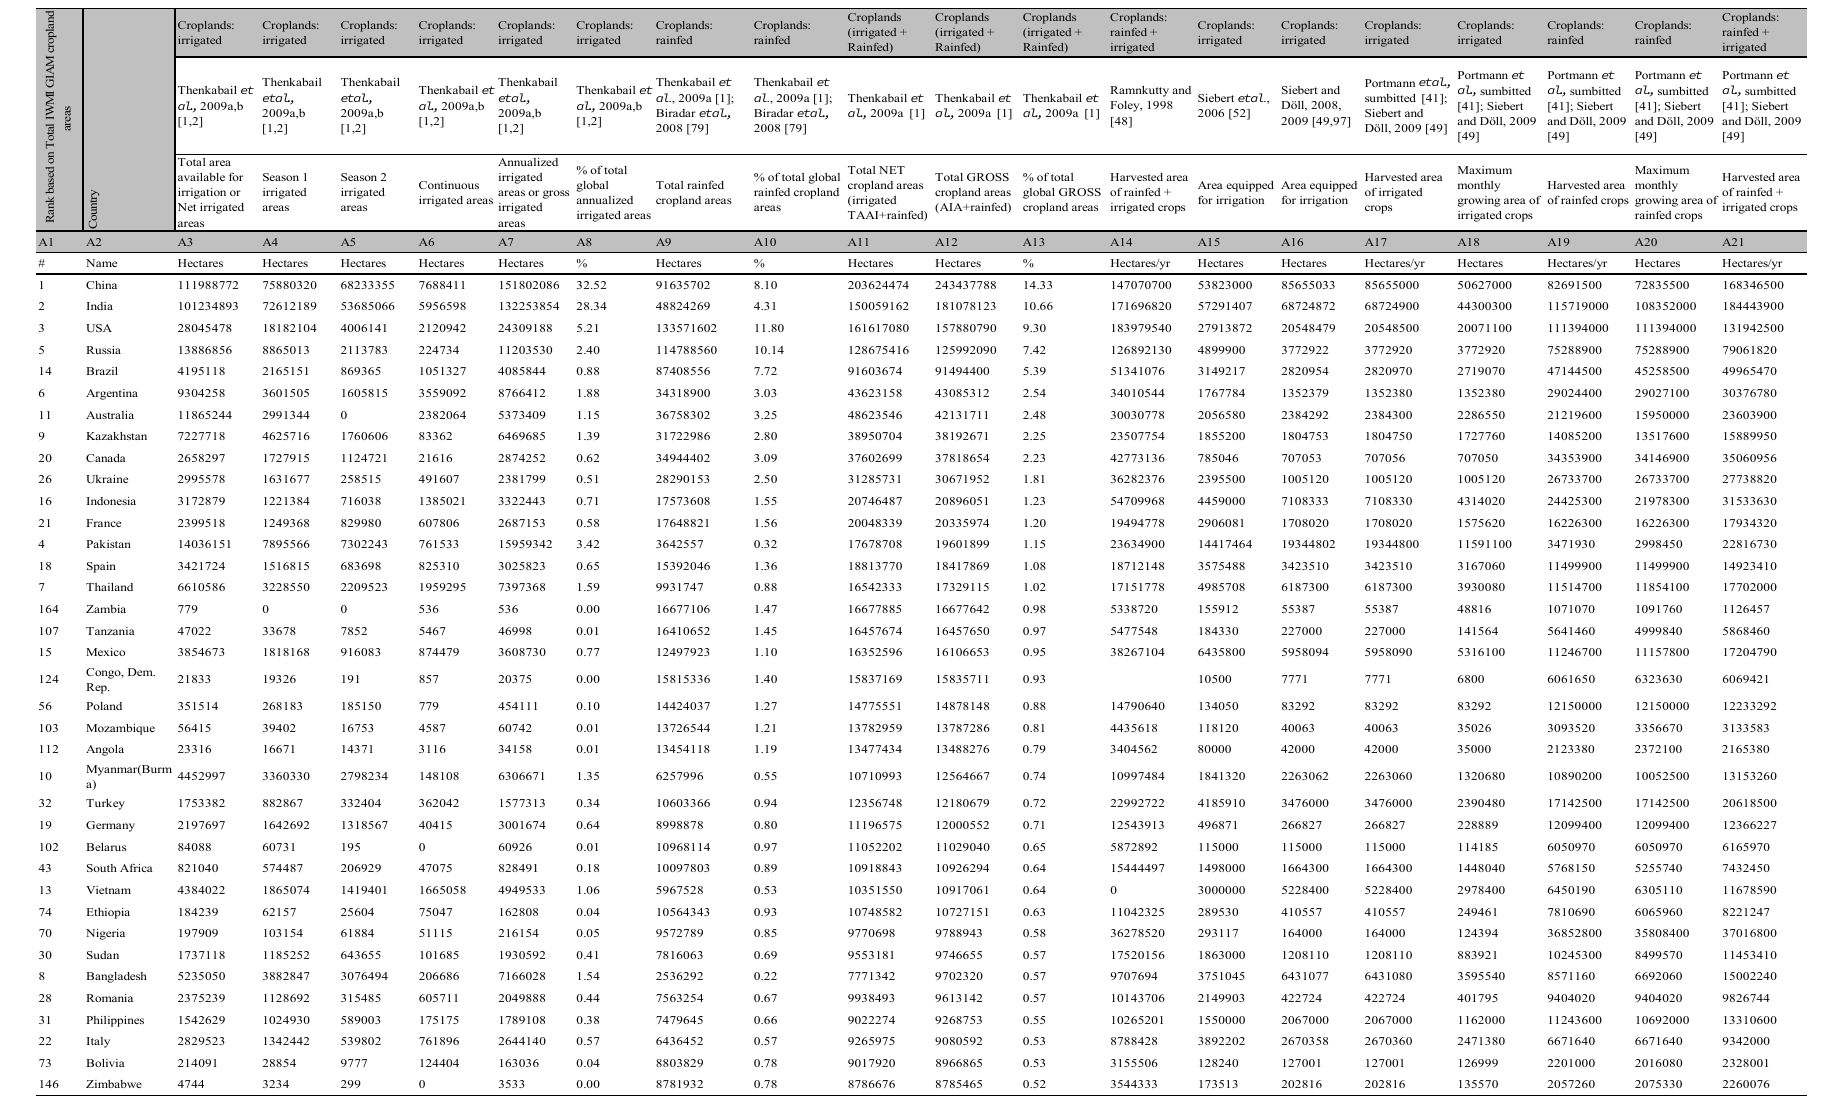
Table 1. Cropland areas and their water use for various countries of the World from a number of different sources. Croplands: